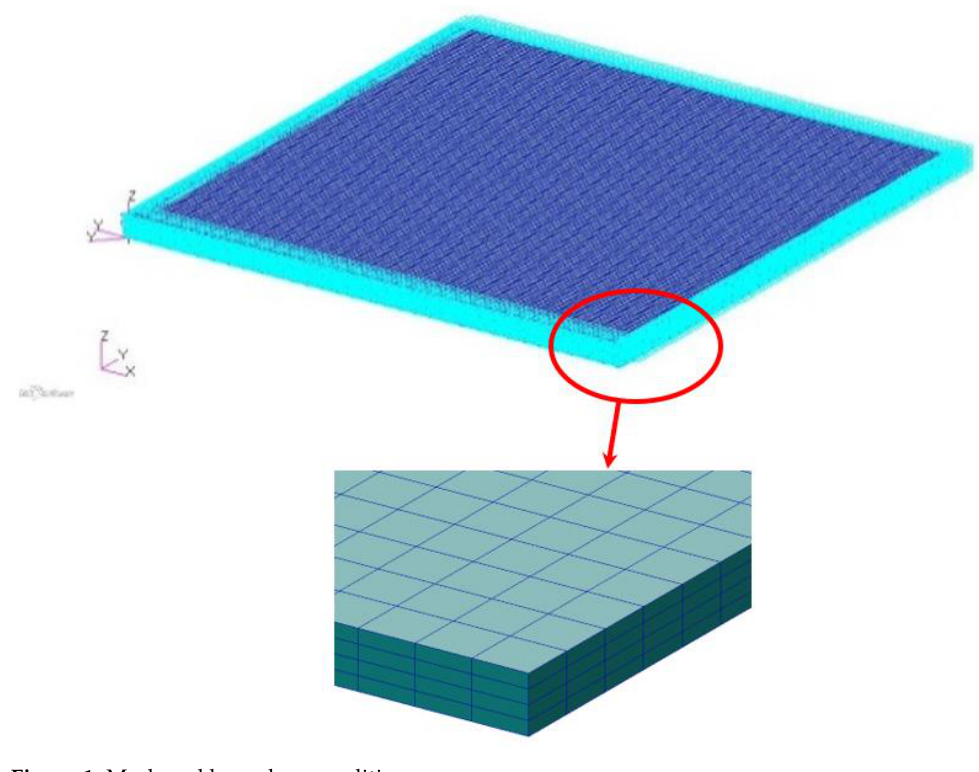
Figure 1. Mesh and boundary condition.